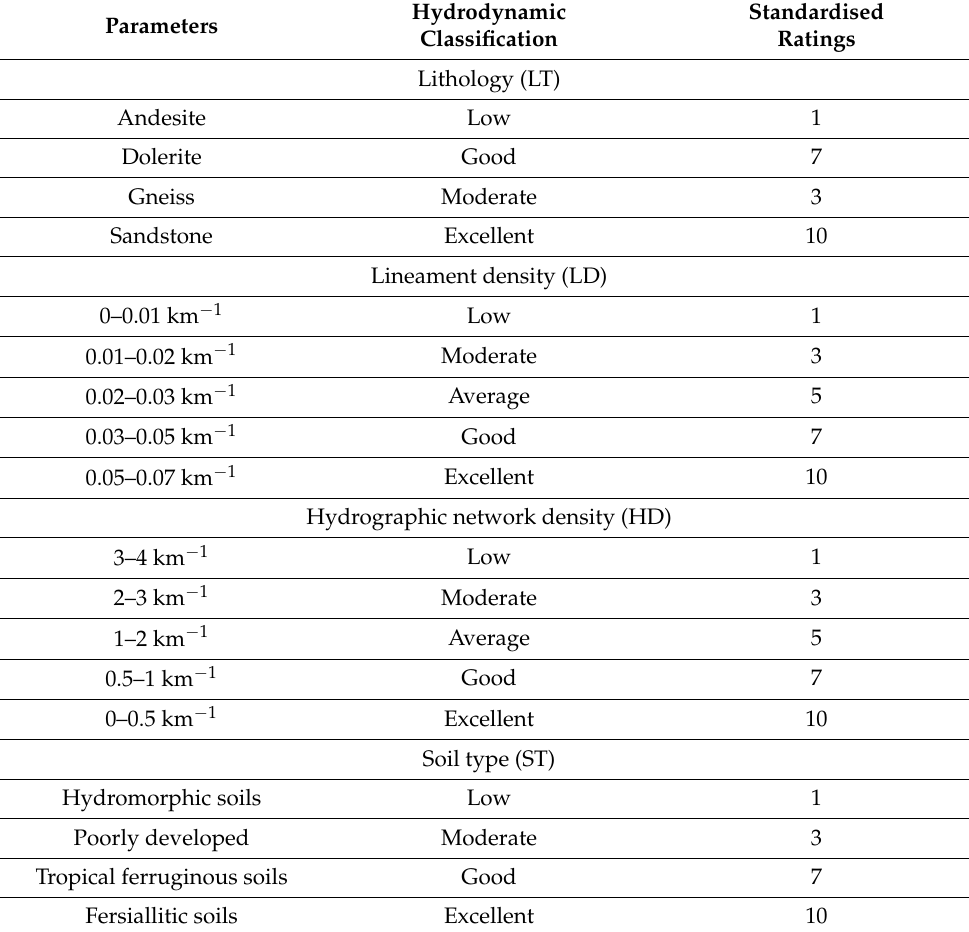
Table 6. Rating of the data for each